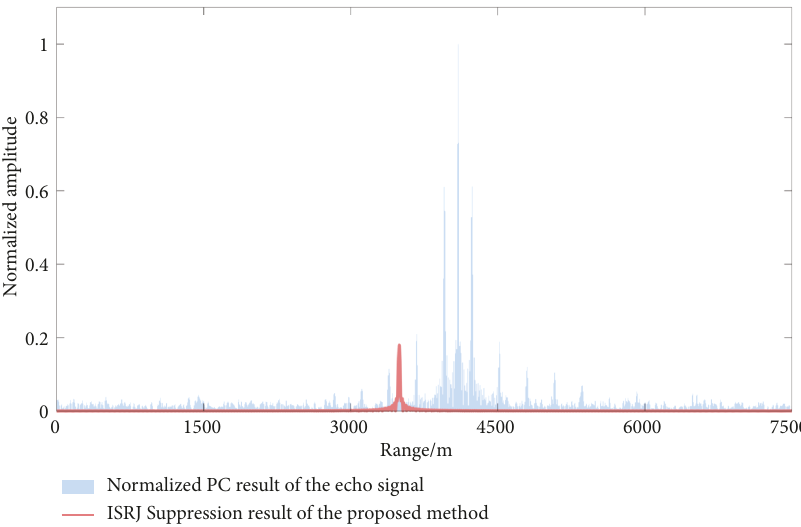
Figure 15: ISRJ suppression result in the frequency shifting